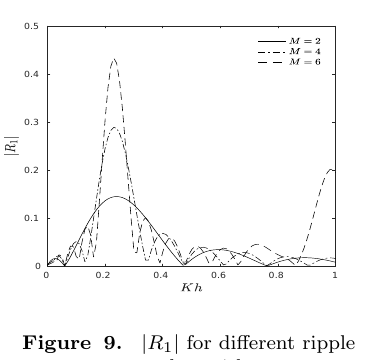
Figure 10. | R 1 | for different ripple amplitude with l 1 /h = 0 . 01 ,l 2 /h = 0 . 2 ,M = 1.